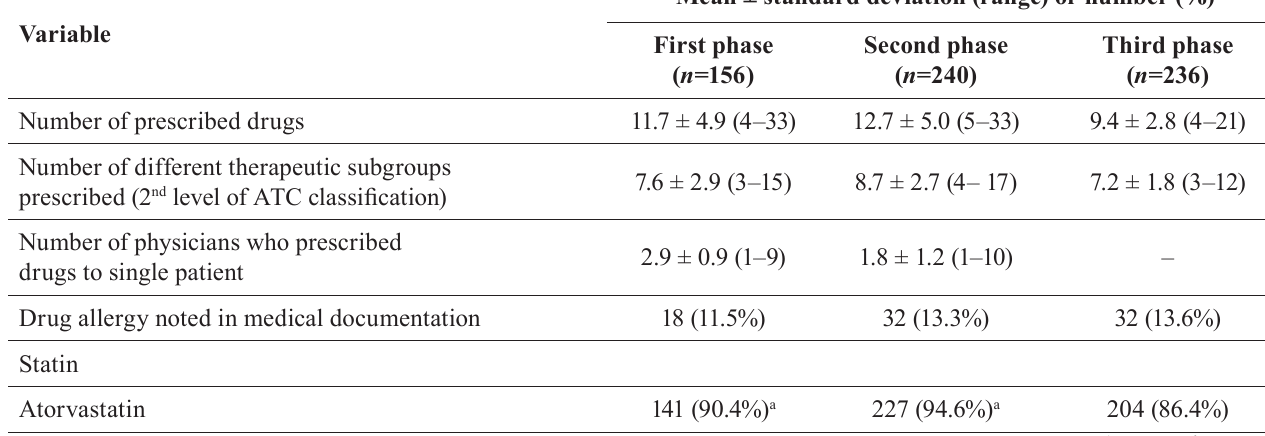
TABLE II - Pharmacotherapy and reperfusion therapy data